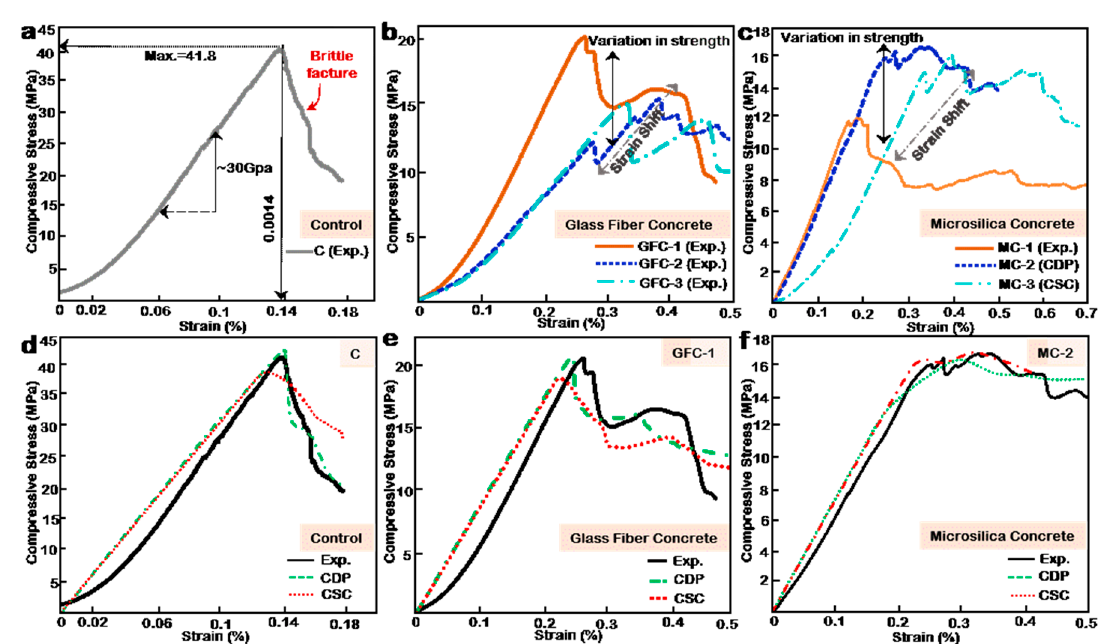
Figure 3. ( a ) Compressive stress–strain curve for the control sample. ( b ) Compressive stress–strain curve for microsilica concrete samples. ( c ) Compressive stress–strain curve for glass fiber concrete samples. ( d ) Numerical simulation and validation of the control sample using Abaqus CSC and CDP models. ( e ) Numerical simulation and validation of GFC-1 sample using Abaqus CSC and CDP models. ( f ) Numerical simulation and validation of MC-2 sample using Abaqus CSC and CDP models.